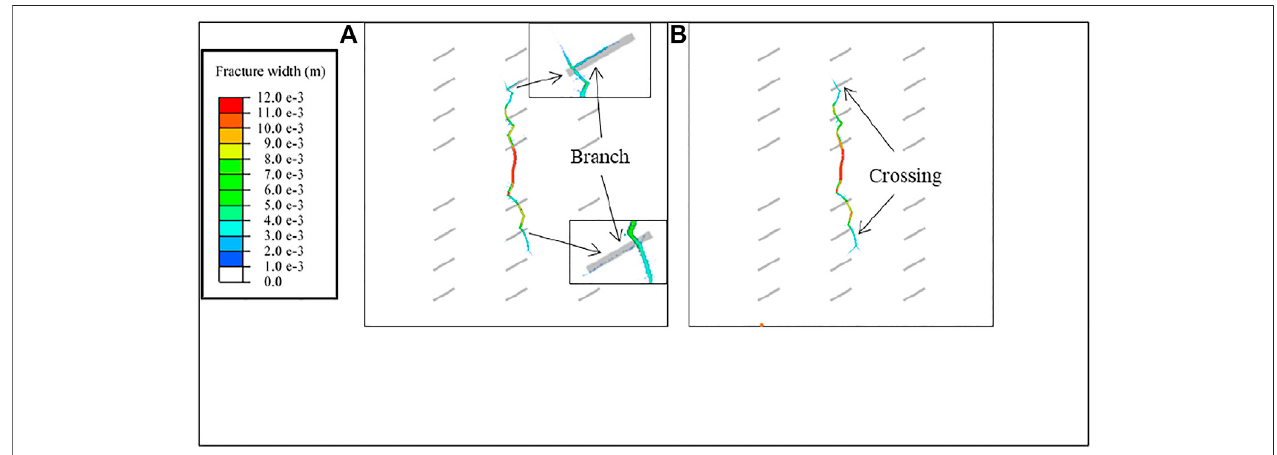
FIGURE 8 | Morphology of hydraulic fracture network under different cement strengths: (A) case 2; (B) case 7.